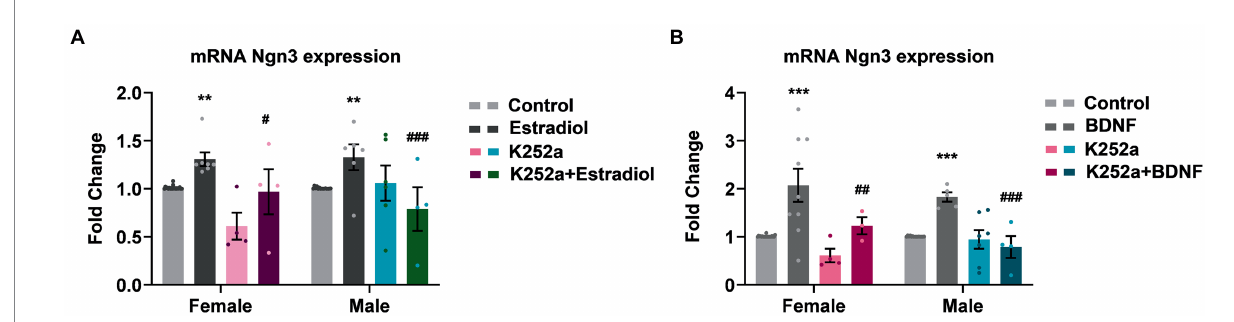
FIGURE 5 Inhibition of TrkB receptor abrogates the effects of estradiol and BDNF on Ngn3 mRNA expression in neurons. (A) Ngn3 mRNA levels in male and female neurons treated with E2, K252a and E2 + K252a. (B) Ngn3 mRNA levels in male and female neurons treated with BDNF, K252a and BDNF + K252a; N = 4. Graphs represent the mean ± SEM; two-way ANOVA with Tukey’s multiple comparisons: ** p < 0.01, *** p < 0.001 vs. control groups; # p < 0.05, ## p < 0.01, and ### p < 0.001 vs. Estradiol or BDNF treated groups.